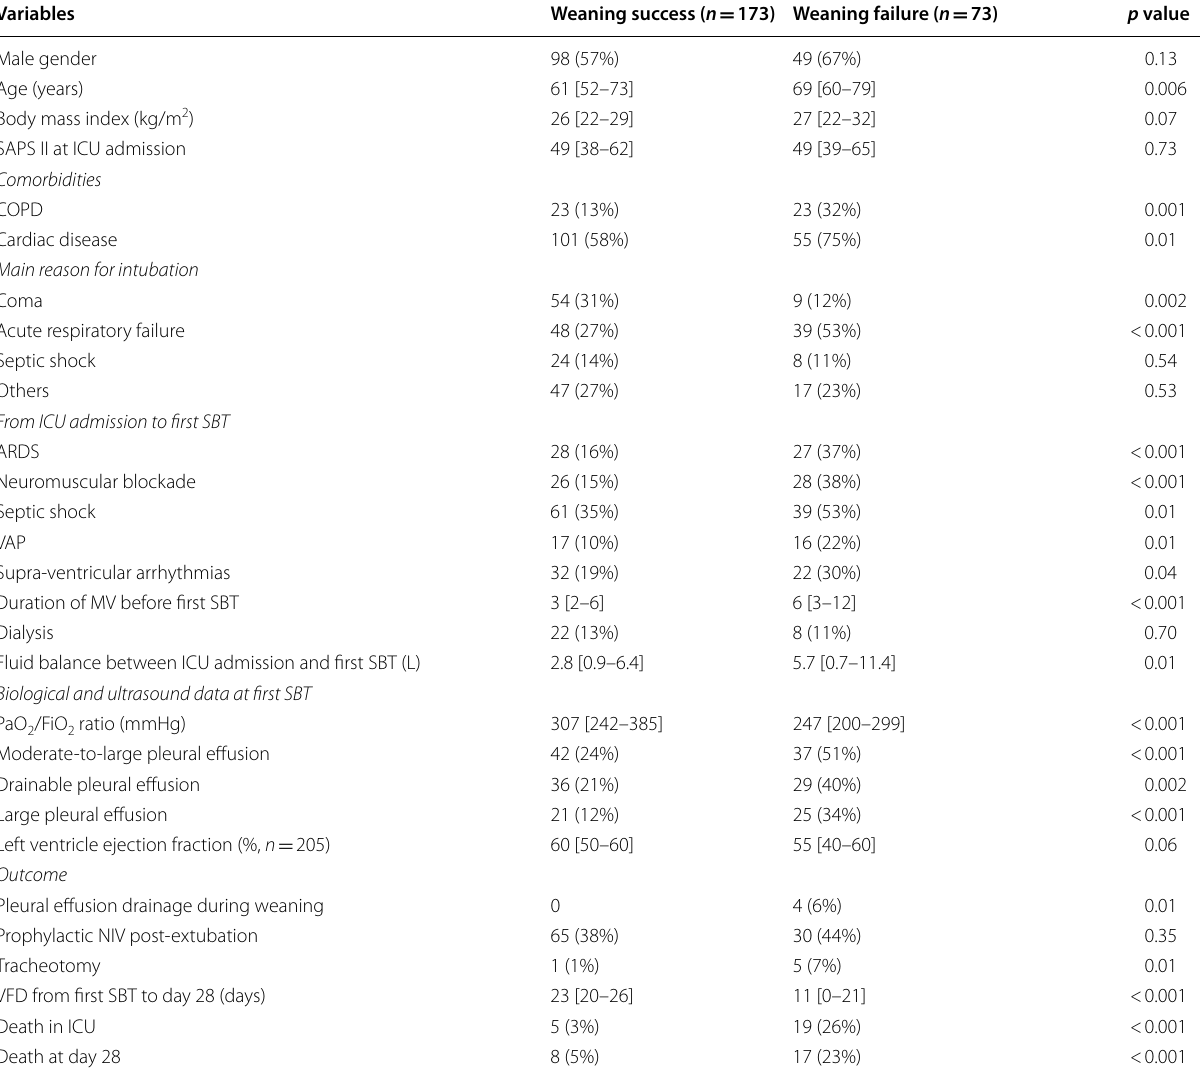
Table 3 Variables associated with weaning failure in 246 mechanically ventilated patients (three patients could not